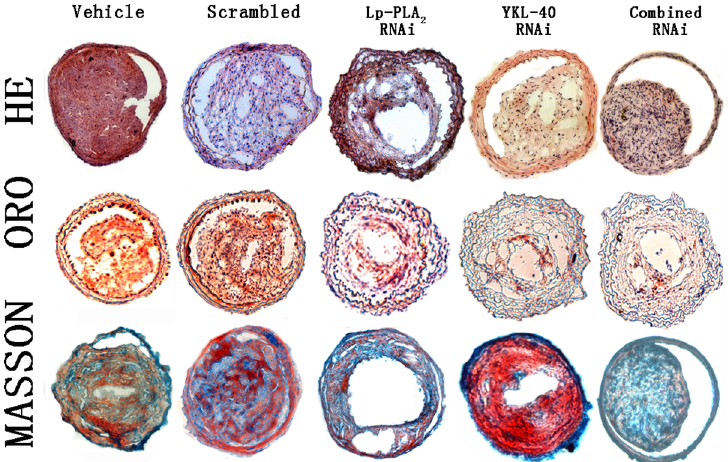
Fig 3. Plaque morphology of the vehicle, scrambled, Lp-PLA 2 RNAi, YKL-40 RNAi, and combined Lp-PLA 2 and YKL-40 RNAi groups. Cross-sections of plaques from all groups were stained with HE, ORO and Masson’s trichrome (n = 12). Magnification